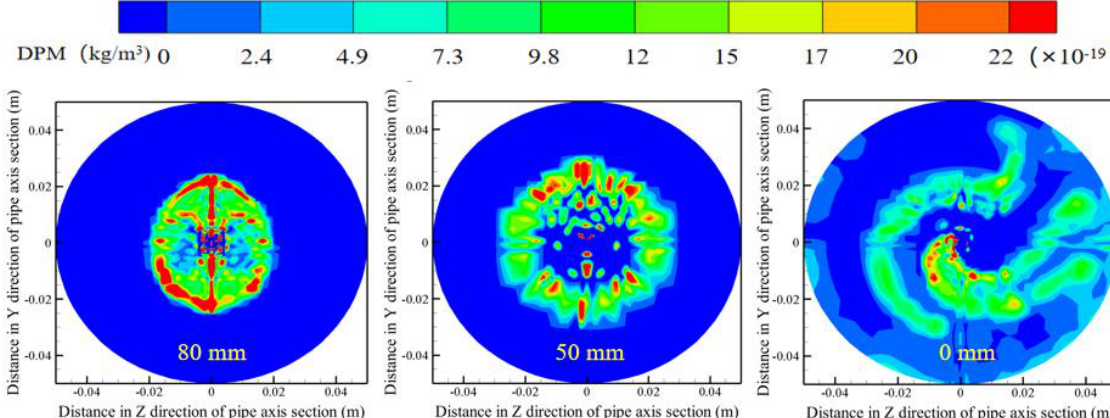
Figure 11. Particle mass concentration distribution with different optimized structures at 0.5 MPa.